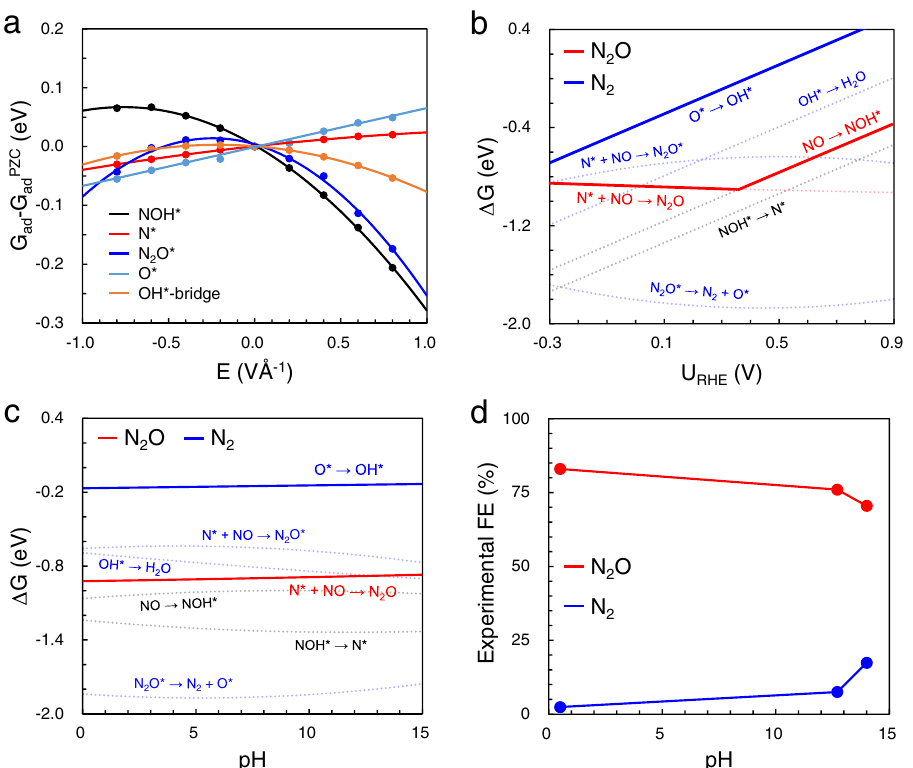
Fig. 6 | Potential and pH effects on product selectivity. a Field effects on inter- mediatesinvolvedinN 2 andN 2 OproductiononPd.The fi ttedvaluesof μ (eÅ)and α (eÅ 2 V − 1 )areshowninSupplementaryTable6. b , c The( b )potential-dependentand ( c ) pH-dependent (0.2V vs. RHE) reaction free energies of steps in the optimum paths towards N 2 and N 2 O on Pd. The blue and red lines refer to steps for N 2 and